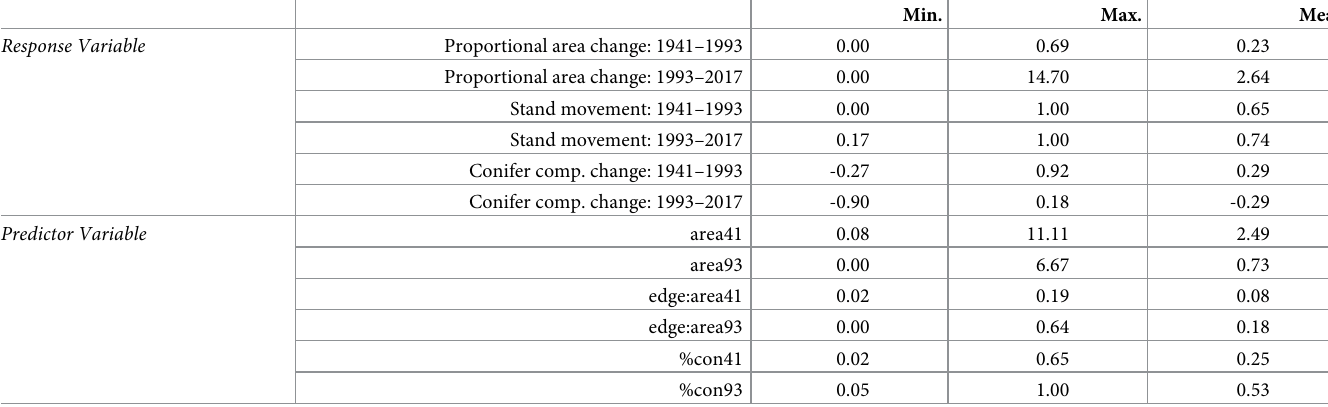
Table 3. Summary data for continuous response and predictor variables.